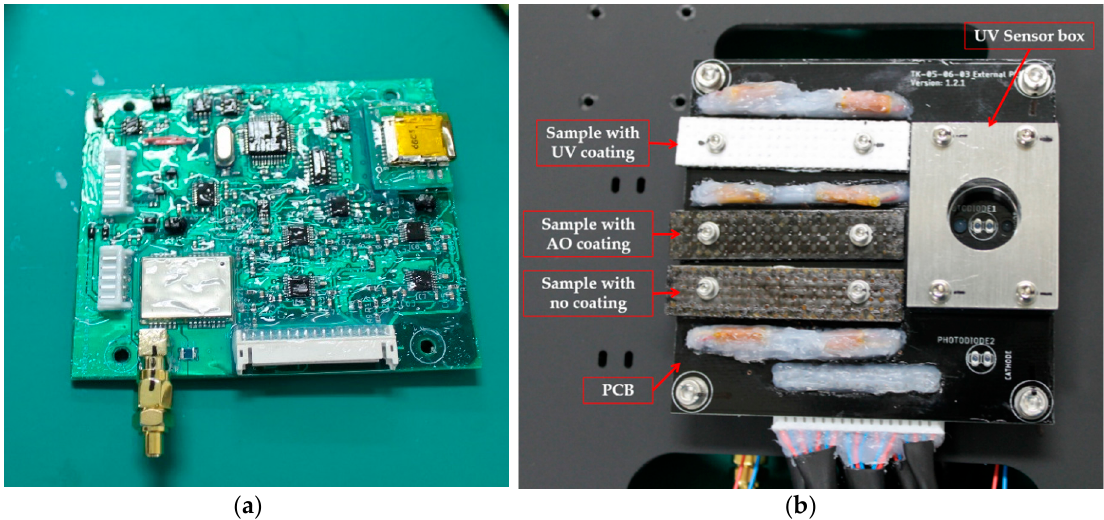
Figure 2. MM main components. ( a ) Internal printed circuit board (PCB) contains MM electronic circuit; ( b ) external PCB contains the Carbon Fibre / Polyether Ether Ketone (CF / PEEK) samples, strain gauges and temperature sensors.